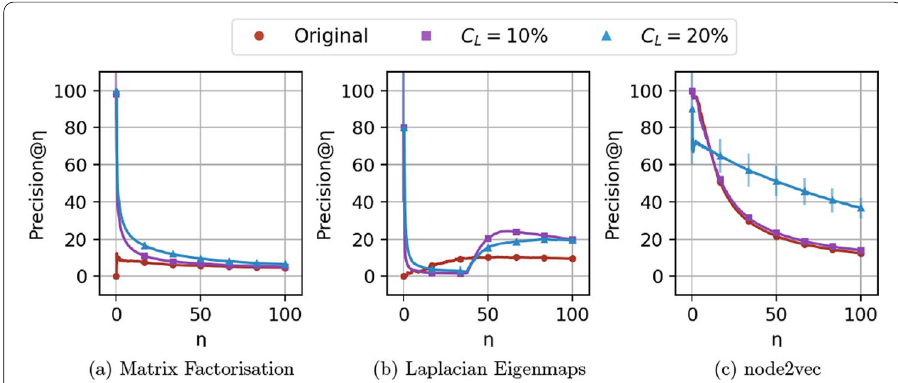
Fig. 11 Precision @ η obtained for network reconstruction, in average, applying each method to each version of the Maayan‑vidal data set (original and rewired). η is expressed in